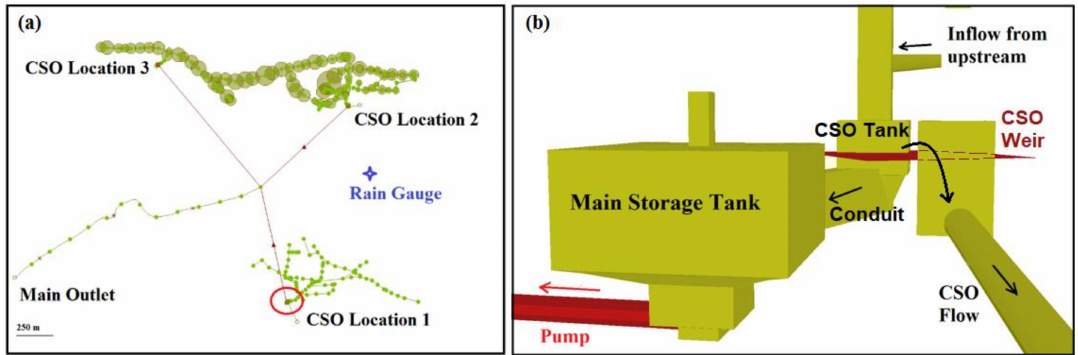
Figure 1. ( a ) Case Study area in InfoWorks ® ICM 8.5 interface; ( b ) Schematic view of combined sewer overflow (CSO) location